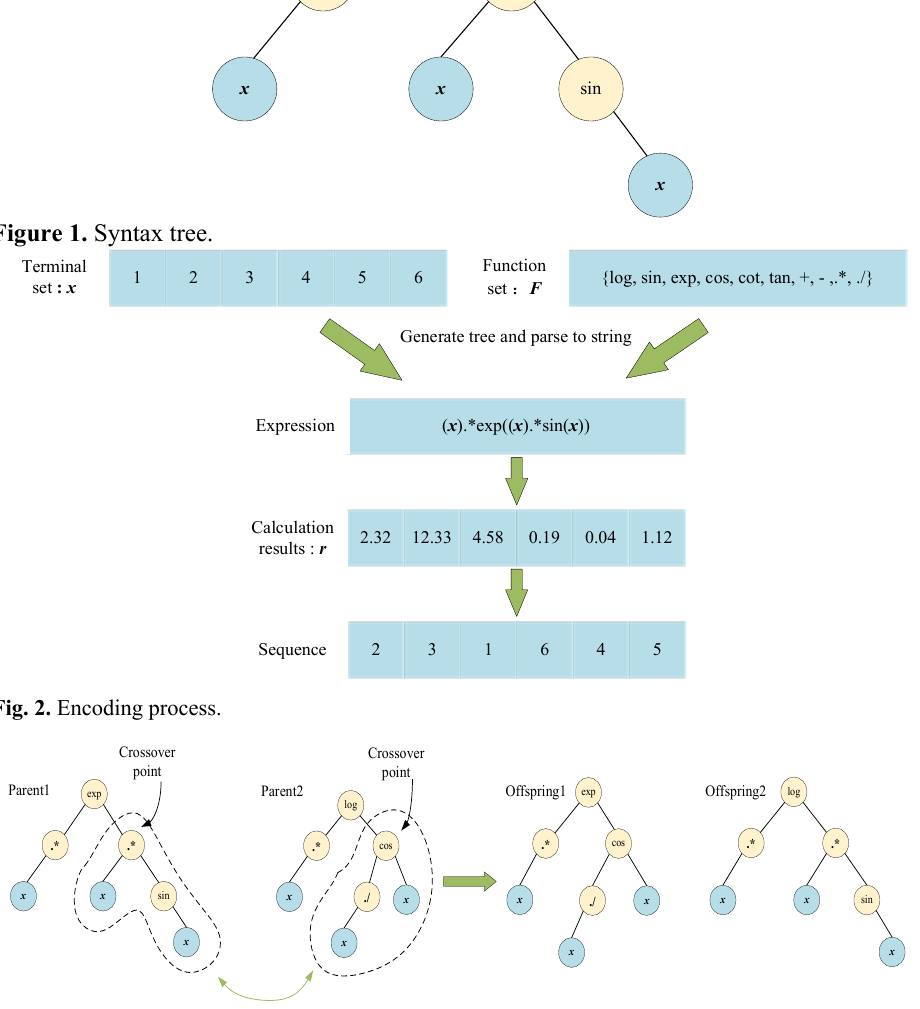
Figure 1. Syntax tree.